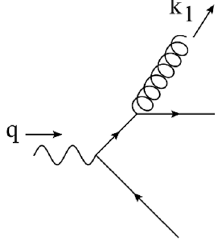
, when the gluon is emitted by the g